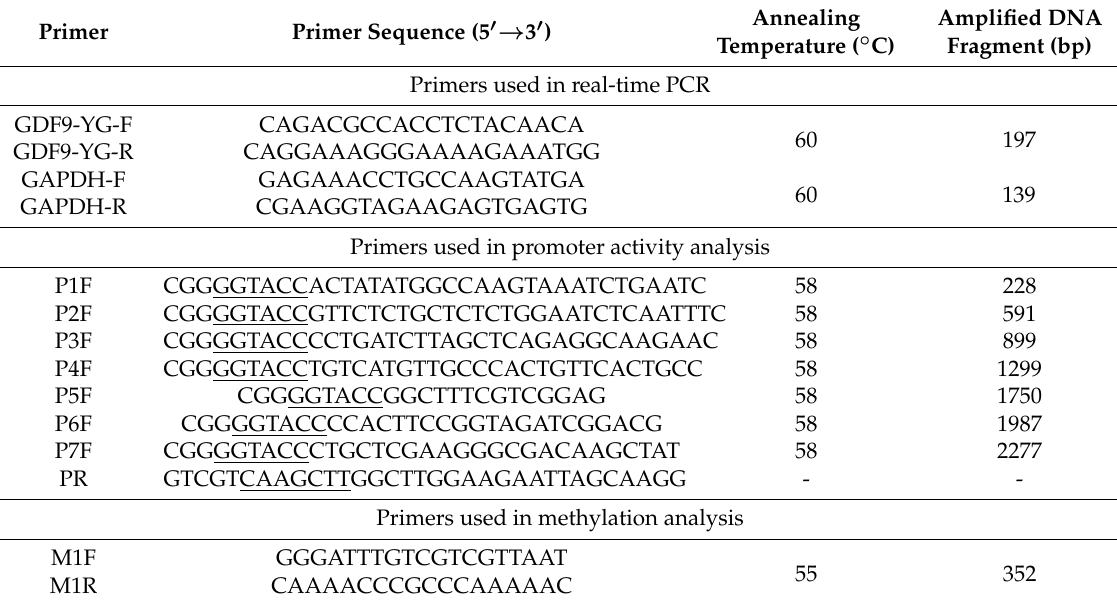
Table 1. Primers used in this study.